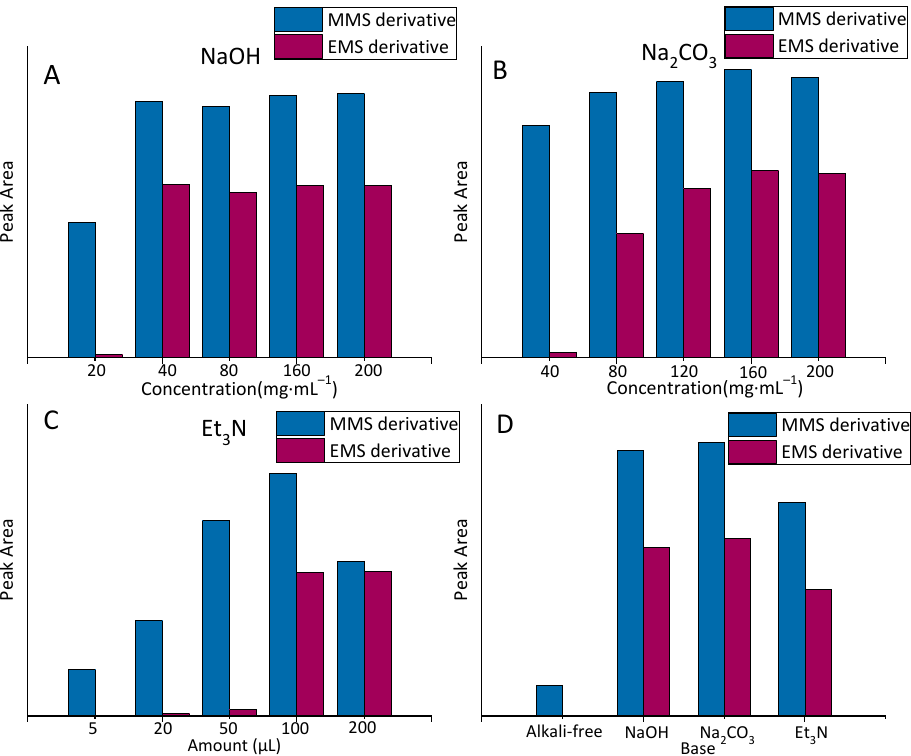
Figure 6. Types and concentrations of base. ( A ) Different concentrations of NaOH; ( B ) different concentrations of Na 2 CO 3 ; ( C ) different concentrations of Et 3 N; ( D ) comparison of the results under the optimal concentration of the three bases.